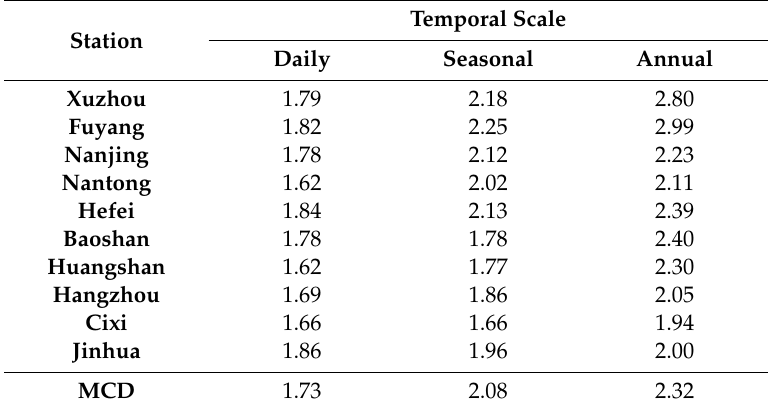
Table 1. The Correlation Dimension (CD) values at daily, seasonal, and annual scales for 68 meteorological stations.